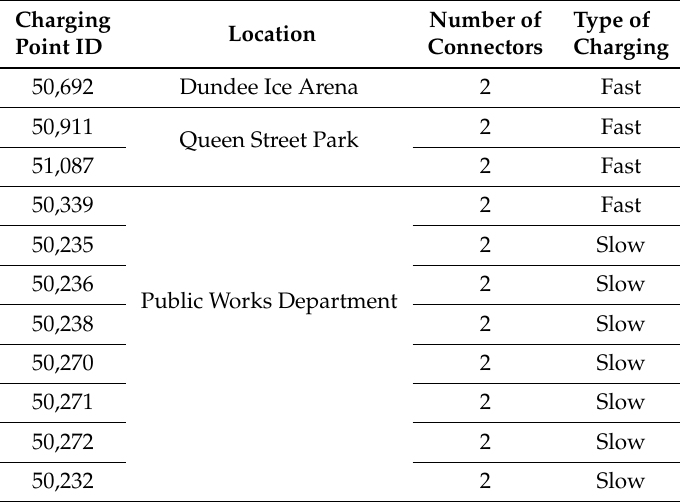
Table 1. Charging Points